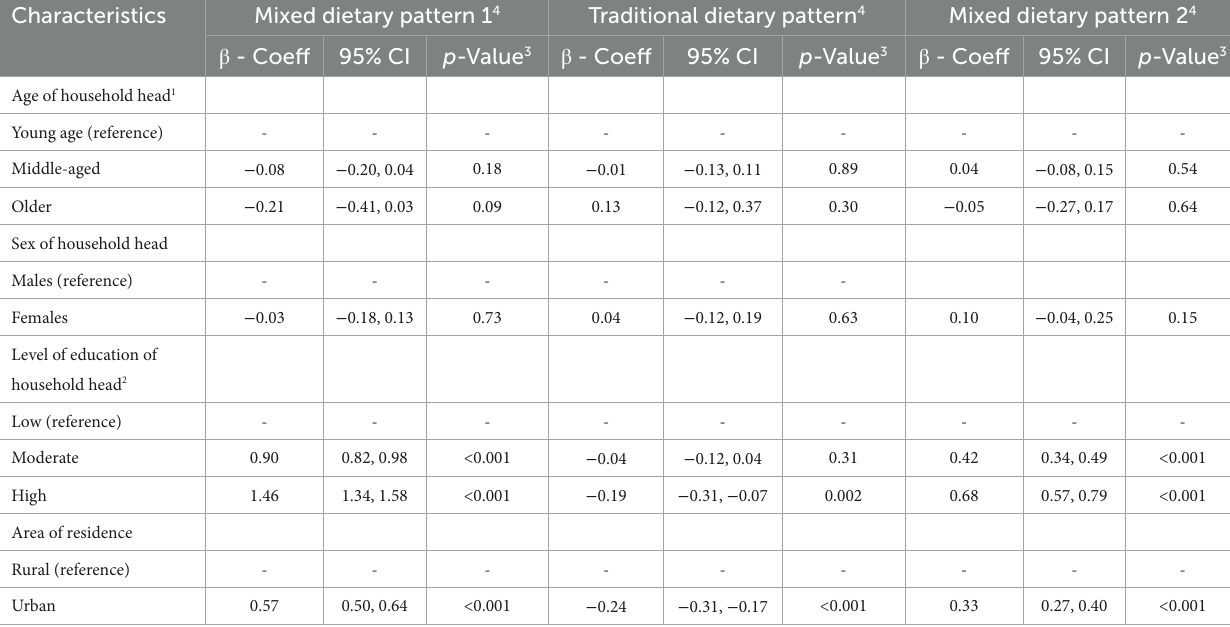
TABLE 3 Associations between sociodemographic characteristics of household heads and principal component dietary patterns (n = 6,833 households).